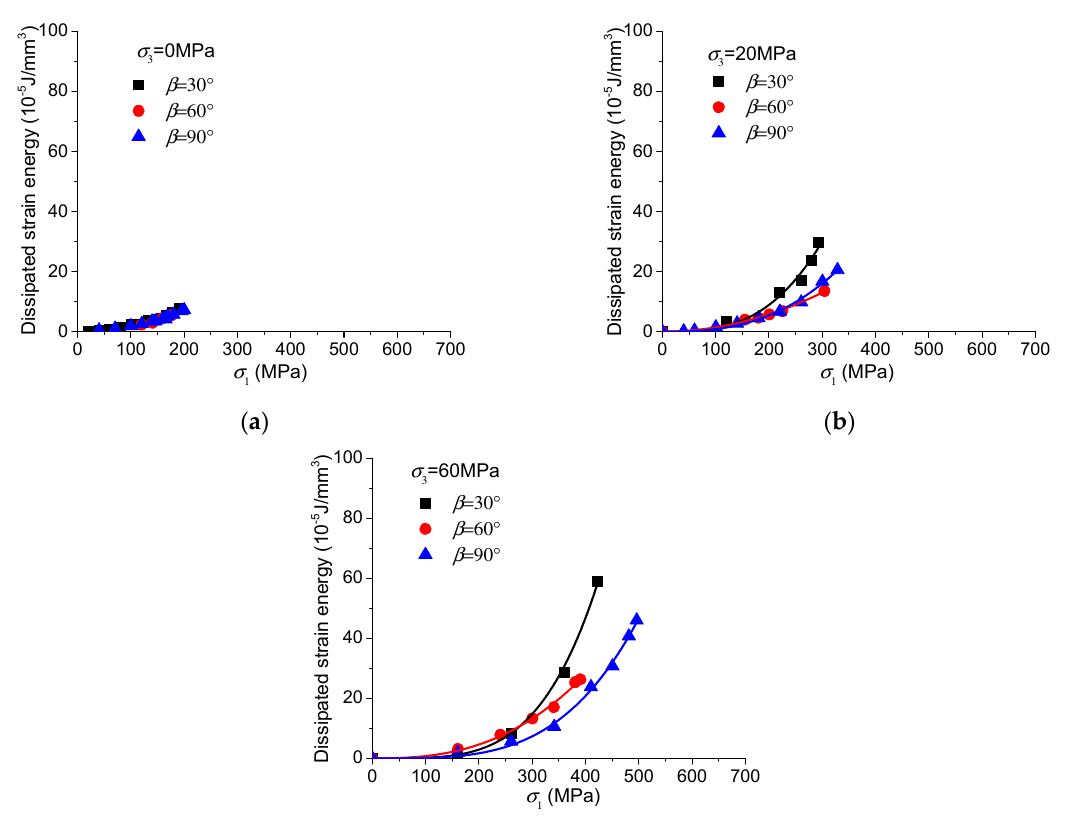
Figure 9. Dissipated strain energy with the increase of axial stress for the shale samples with different oriented weak planes (( a ) β = 30 ° , ( b ) β = 60 ° , and ( c ) β = 90 °) under various confining pressures.